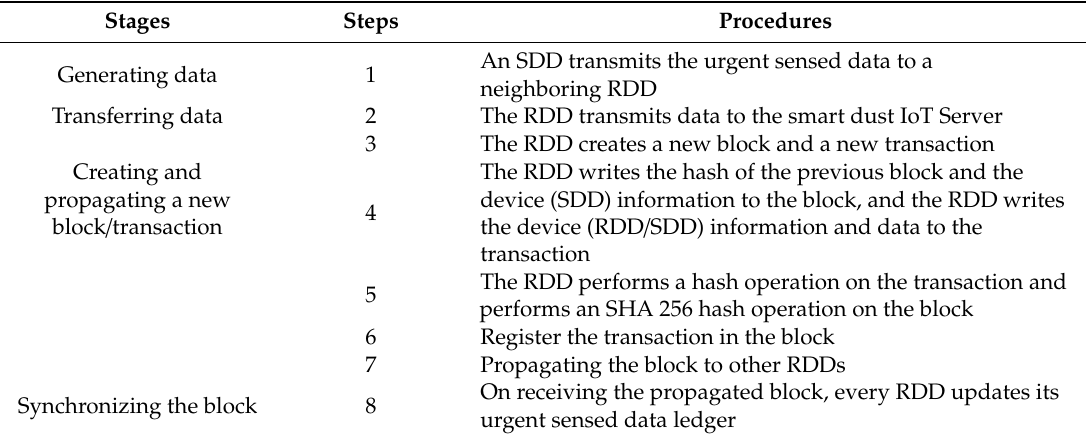
Table 3. The urgent sensed data blockchain processing procedure.